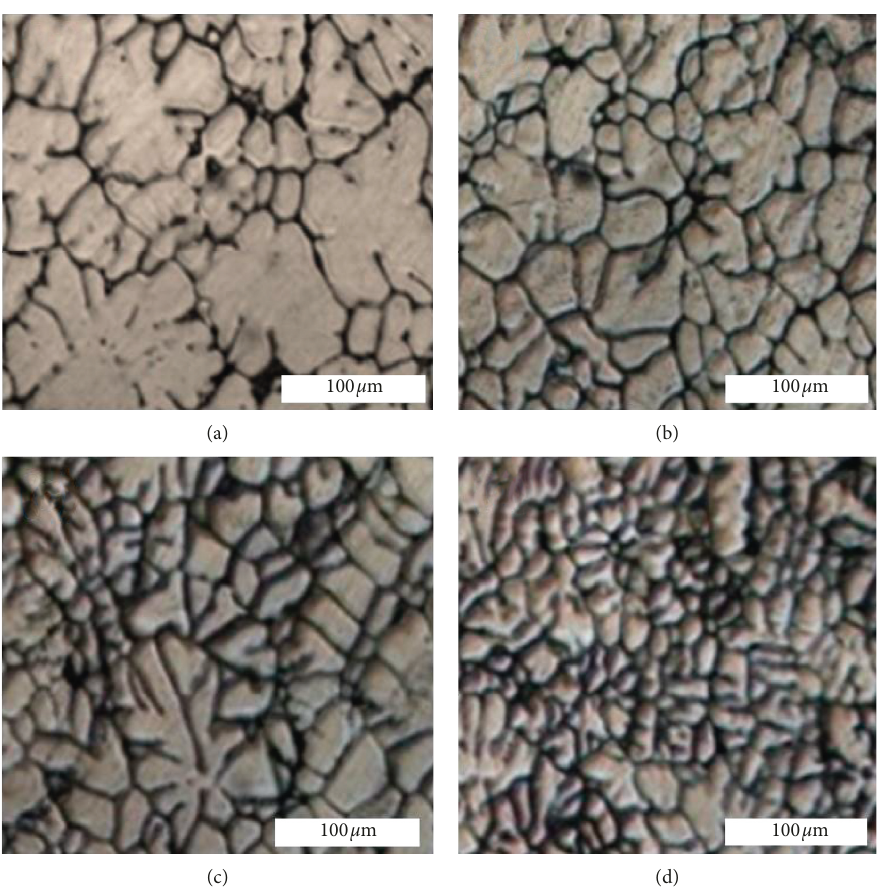
Figure 5: Microstructure of 2017A alloy in as-cast conditions: (a) P